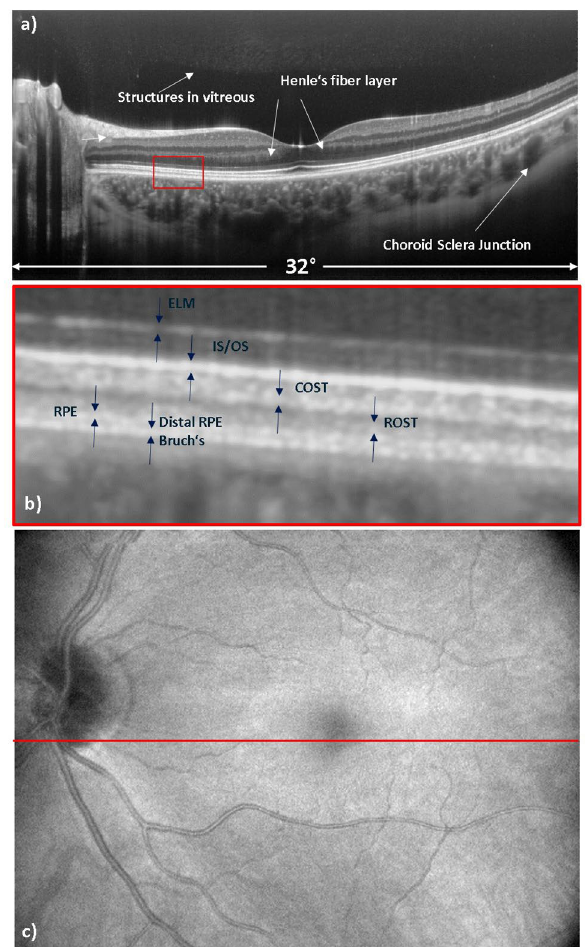
Figure 2. Representative OCT images recorded with the large field of view imaging mode in the healthy subject where ( a ) shows an average over 200 B-scans recorded at the same location, ( b ) shows an enlarged view of the posterior layers of the retina, and ( c ) shows the en-face intensity projection image of the volume scan. The red line at the center of the OCT en-face image indicates the location of the averaged B-scan image. ELM, external limiting membrane; IS/OS, inner and outer segment junction; COST, cone outer segment tips; ROST, rod outer segment tips; RPE, retinal pigment